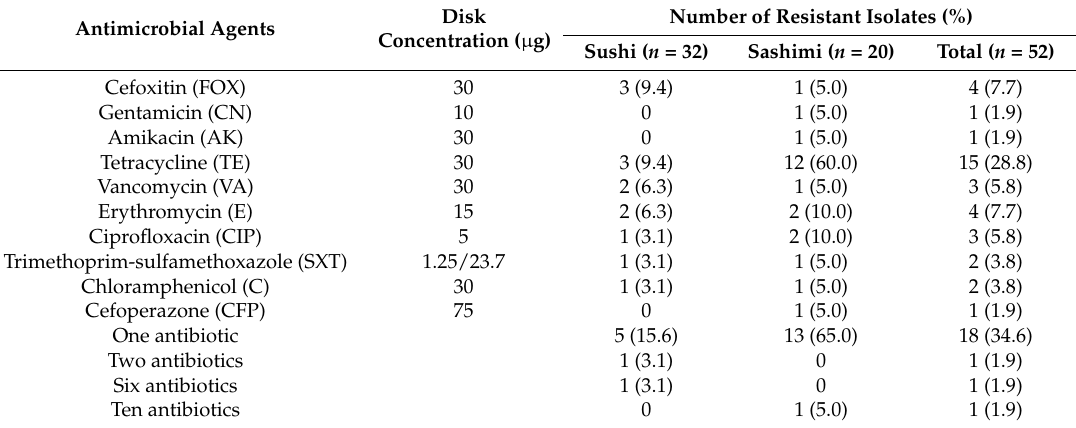
Table 3. Frequency of antimicrobial resistance in 52 Staphylococcus aureus isolates recovered from sushi and